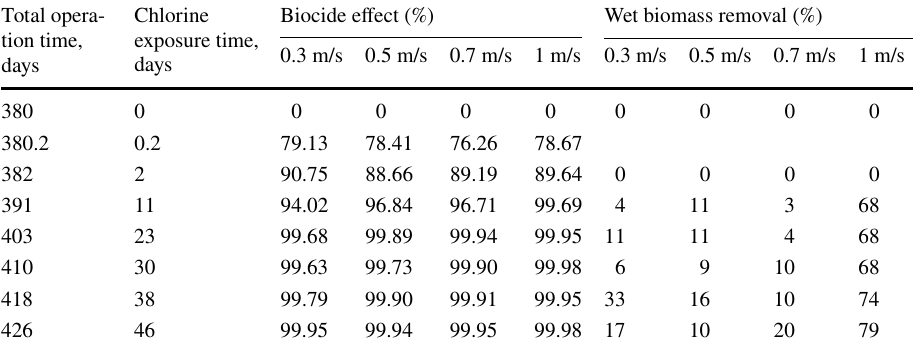
Total opera- tion